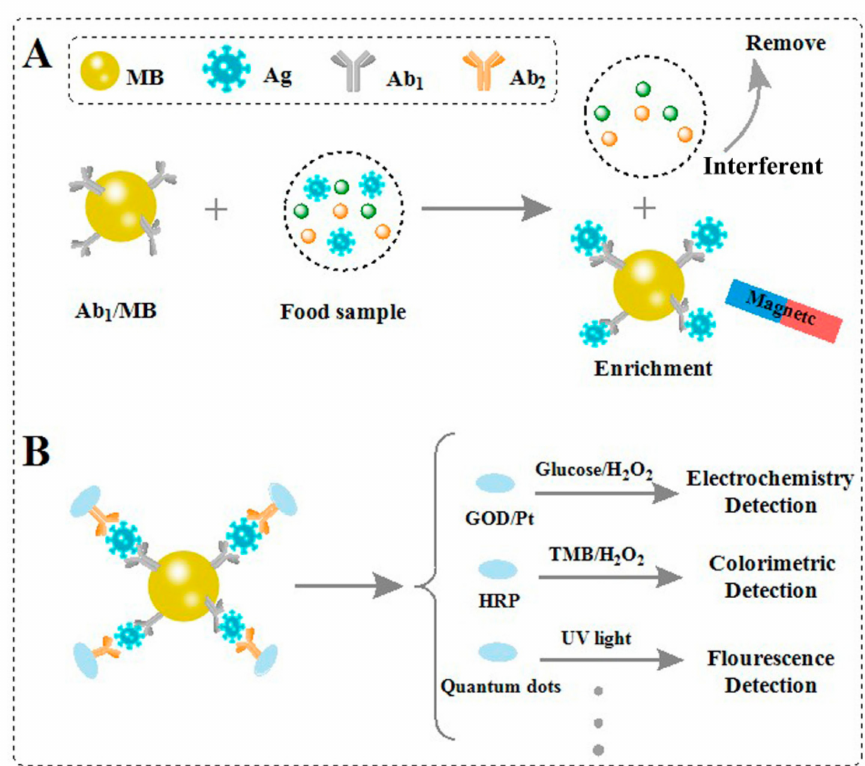
Figure 7. Schematic presentation of virus detection in food samples: ( A ) the magnetic separation technique for virus; ( B ) different immunoassays for virus